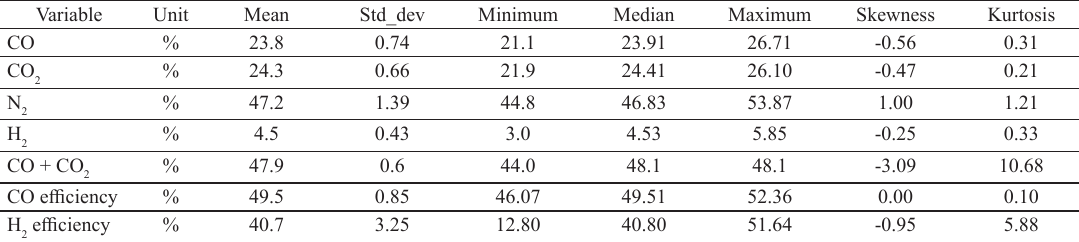
Figure 6. Artificial neural network architecture. Table 6. Top gas variables.